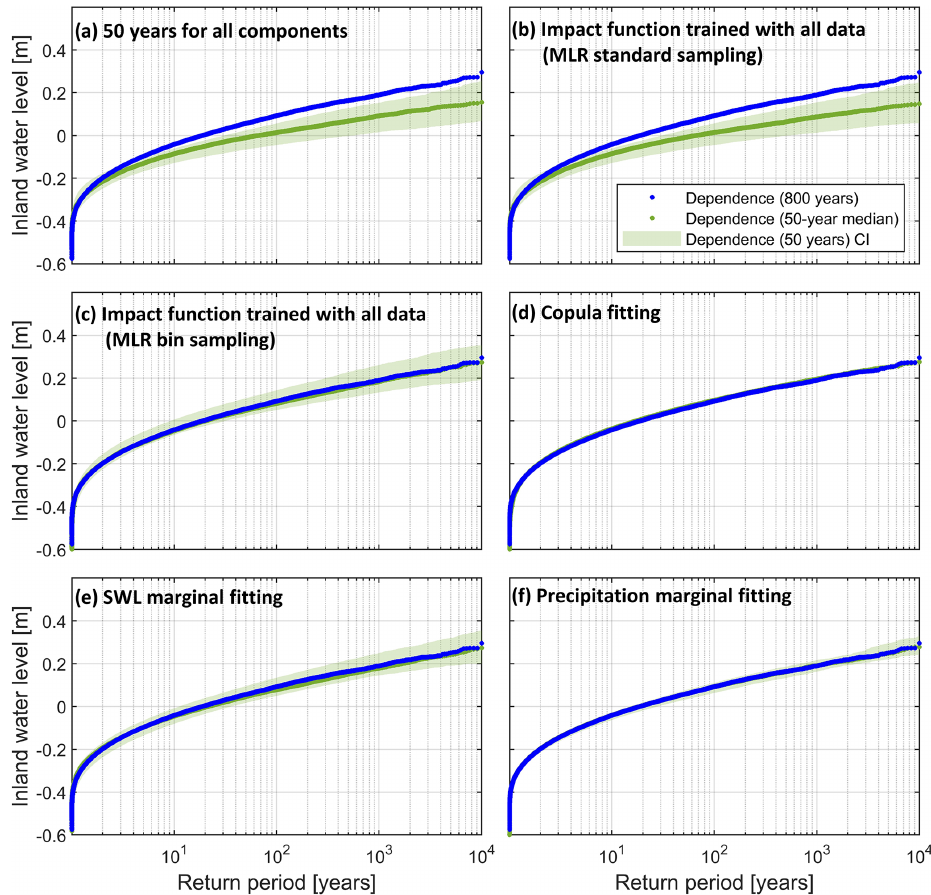
Figure 9. IWL return level against estimated return period using a bivariate copula. Blue dots depict the return level estimates obtained using the proposed statistical framework (using 800 years of data). Transparent green illustrates the uncertainty associated with internal climate variability, represented by bounds computed using the 5th and 95th percentiles from all 50-year ensembles. Opaque green shows the median value computed from all ensembles. This is assessed for each component of the methodology: (a) 50-year ensembles are used for all components; (b) same as (a) but MLR impact function is trained with standard sampling using 800 years of data; (c) same as (b) but using bin-sampling approach; (d) 50-year runs are used for copula fitting only; (e) 50-year runs are used for SWL marginal fitting only; and (f) 50-year runs are used for precipitation marginal fitting only (see Table